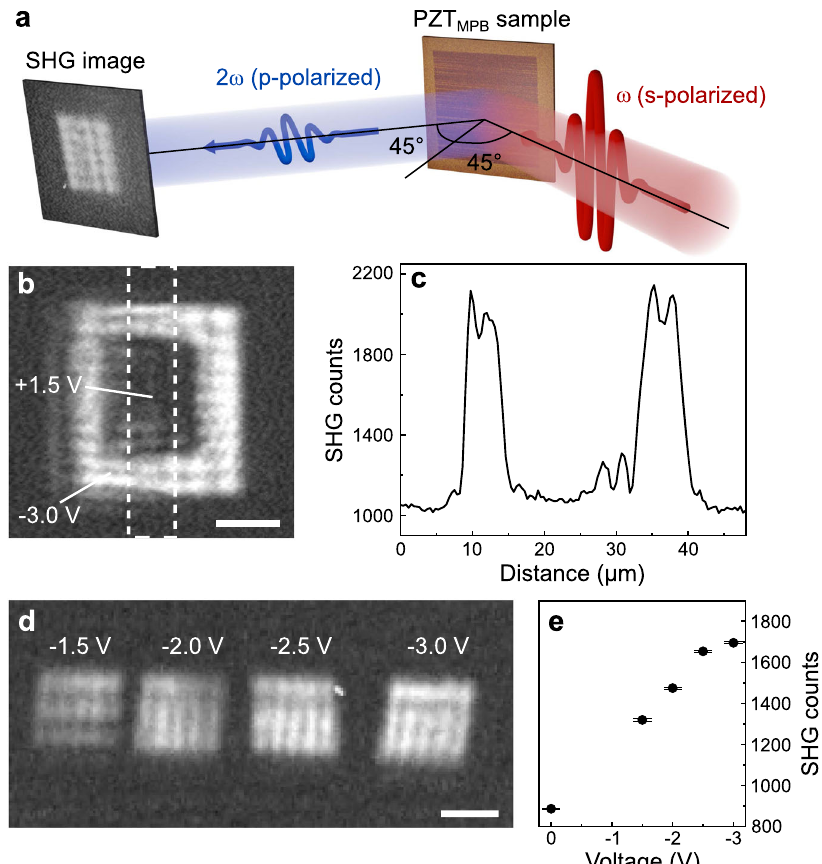
Fig. 3 Continuous tunability of the SHG emission via DC voltage application. a Schematic SHG imaging setup in 45° re fl ection. b SHG image after applying − 3.0/ + 1.5 V to a box-in-box region. The inner box shows the reversibly depolarized SHG-inactive state. c Cross-section of the SHG signal across the dashed outline in ( b ). d SHG image containing four neighboring 15 × 15 μ m 2 square areas, where the poling voltage is gradually increasing from left to right. Scale bars in b , d 10 μ m. e Spatially averaged SHG signal for each poled area and the pristine background in d as a function of the applied voltage with indicated standard